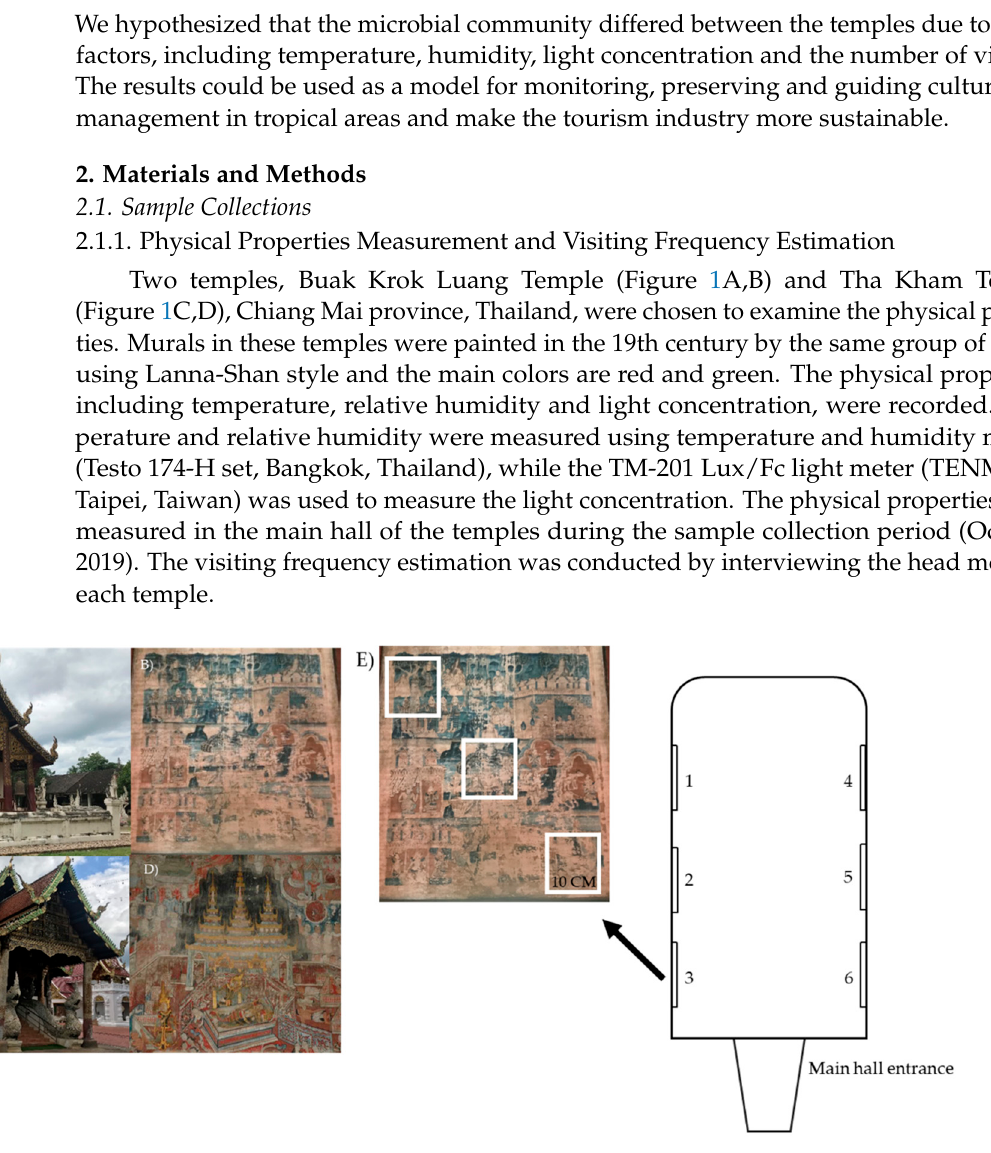
Figure 1. Buak Krok Luang Temple ( A ), mural painting of the Buak Krok Luang Temple ( B ), Tha Kham Temple ( C ), mural painting of the Tha Kham Temple ( D ) and sampling areas within the temples, the white frames demonstrate 3 sampling replications in each area ( E ).